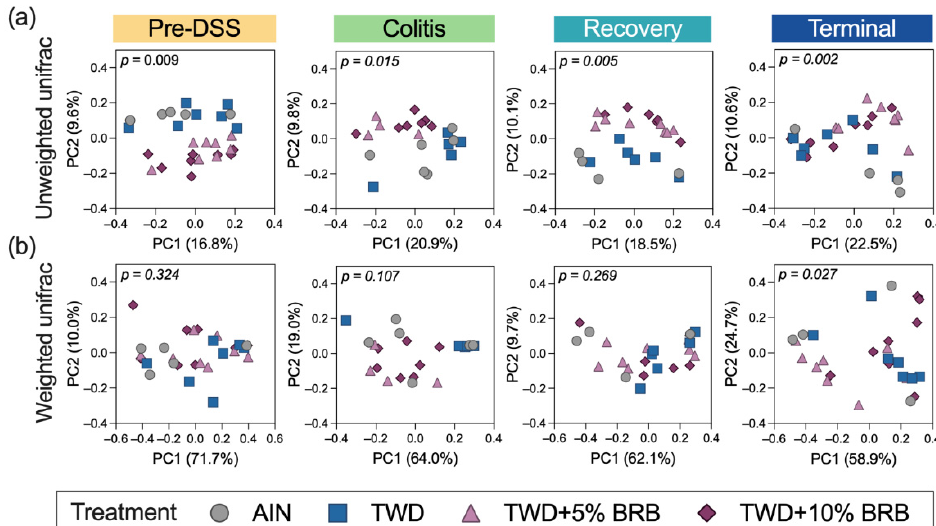
Figure 2. Beta diversity of mouse microbiomes at each experimental time point (experiment A). Principal coordinate plots depicting fecal microbiome beta diversity using ( a ) unweighted or ( b ) weighted unifrac distances are shown with the two components. The variation attributed to PC1 and PC2 along with the permanova p -values are provided for each plot.